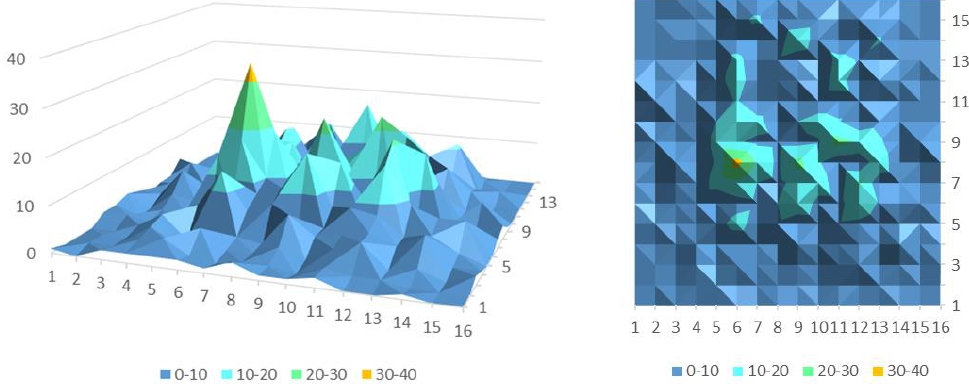
Figure 10. Actual travel demand distribution map in the hotspot area.